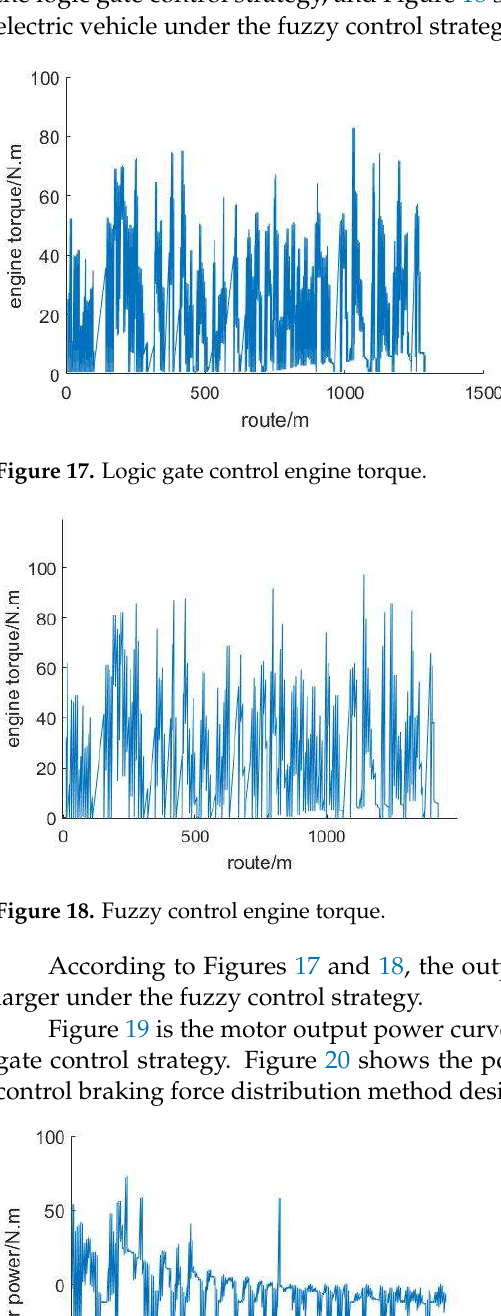
Figure 16. Simulation effect of controller.